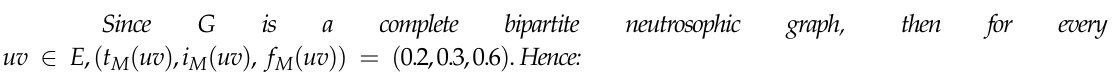
Figure 4. An example of a complete bipartite neutrosophic